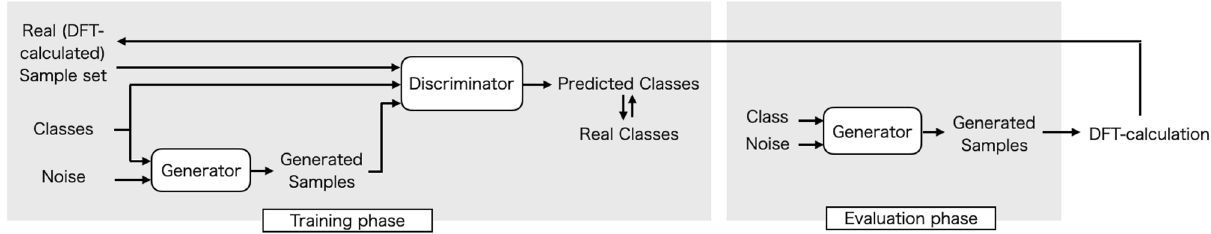
Figure 2. Structure of the DFT-GAN procedure used in this study. In the training phase, the generator and discriminator are trained using DFT-calculated data. Then, new samples are generated in the evaluation phase. This training−evaluation sequence consists of one iteration. After the newly generated samples are evaluated by DFT calculations, they are added to the original dataset for use in the subsequent